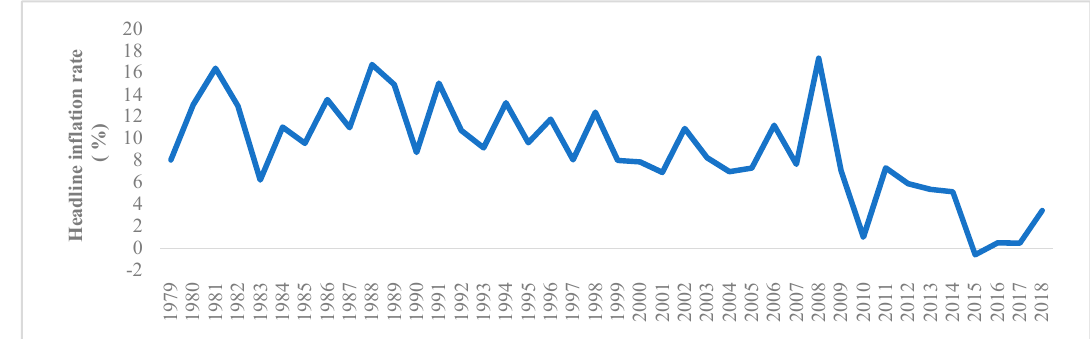
Figure 3. Annual headline inflation rate in Solomon Islands, 1979–2018. Data from WorldData.info. (WorldData.info